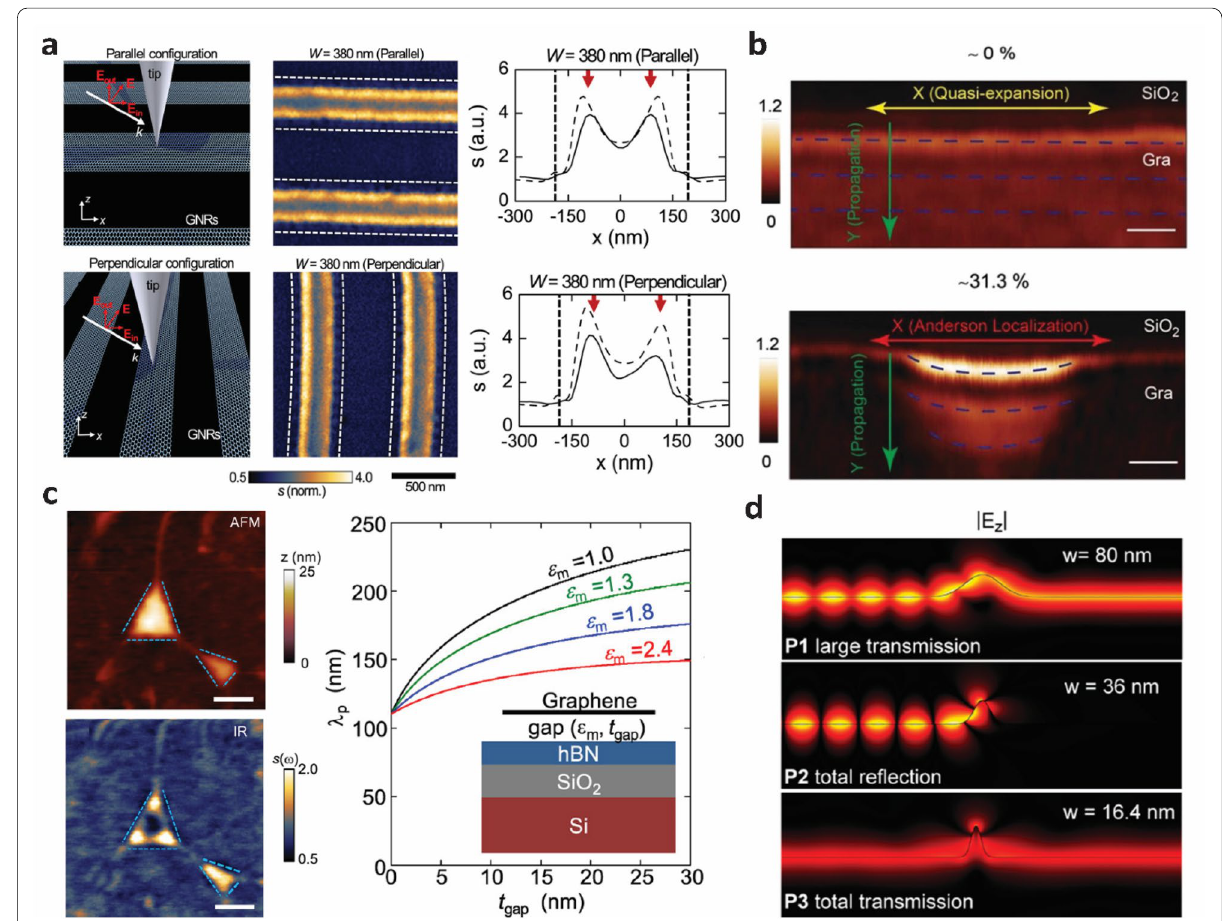
Fig. 1 Graphene plasmons in graphene nanoribbons ( a ) and graphene with structural defects ( b – d ). a AFM-IR imaging with two different laser excitation configurations (left) and corresponding AFM-IR images of graphene nanoribbons at each configuration showing the orientation dependent near-field intensity. Schematics of the AFM-IR imaging (left), near-field images (middle) and line profile of the near-field images (right) when the E-field of the excitation was parallel (top) and perpendicular (bottom). The ribbon edge and fringe locations are denoted by the dashed line and red arrows on the line profiles. Laser excitation frequency was 1184 cm − 1 . Reproduced with permission from [30]. Copyright 2017 American Chemical Society. b Near-field images of ordered or quasi-expansion (top) and highly disordered or Anderson localized (bottom) graphene at 901 cm − 1 excitation comparing the plasmonic confinement between the two graphene edges. The blue dashed lines represent the fringe pattern. Scale bar is 300 nm. Reproduced under the terms of the Creative Commons License from [34]. Copyright 2019 The Authors. Published by WILEY-VCH Verlag GmbH & Co. KGaA, Weinheim. c AFM topography (top left) and nano-IR image (bottom left) of graphene nanobubbles at 910 cm − 1 excitation showing plasmonic confinement at the bubbled regions. The boundaries of the nanobubbles are shown in blue dashed line in the nano-IR image. Scale bar is 200 nm. Right panel shows the theoretical calculation of plasmon wavelength and dispersion diagram of the graphene nanobubble structure. The bubble area is represented by the gap shown the inset schematics. Reproduced with permission from [35]. Copyright 2016 American Chemical Society. d Interaction of plasmon wave with a graphene wrinkle with three different widths (W). Reprinted with permission from [36]. Copyright 2017 American Chemical